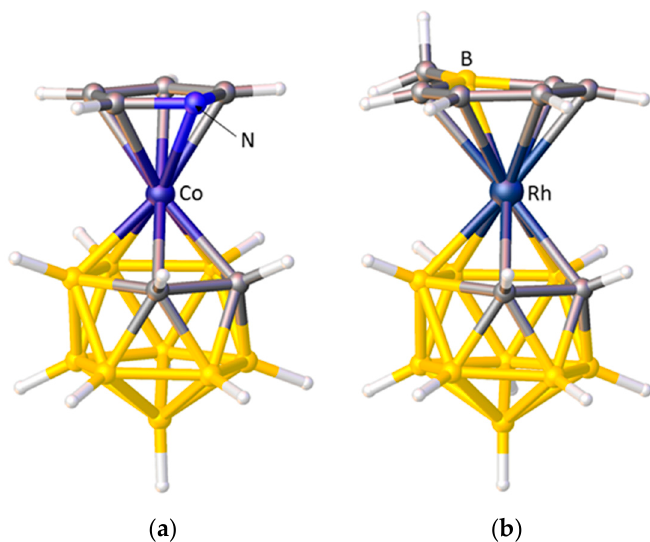
Figure 7. ( a ) The structure of [3-(C 4 H 4 N)- closo -3,1,2-CoC 2 B 9 H 11 ]. Note the N atom of the pyrrolyl ligand lies above the cage C atoms; ( b ) The structure of [3-(C 5 H 5 BMe)- closo -3,1,2-RhC 2 B 9 H 11 ] in which the B atom of the boratabenzene ligand is trans to the cage C atoms.